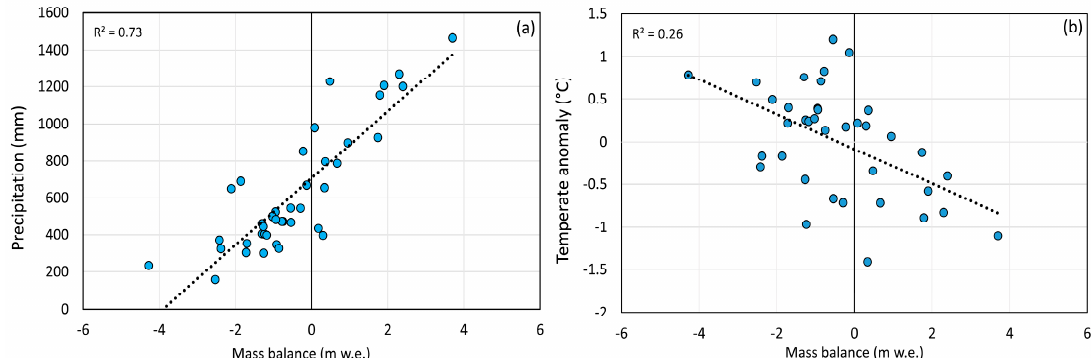
Figure 6. ( a ) Correlation analysis between glacier mass balance of the Echaurren Norte Glacier with annual precipitation and ( b ) annual temperature anomalies [65]. It is noteworthy that a higher correlation between mass balance and precipitation is observed (meteorological data from El Yeso weather station, 2474 m a.s.l.).